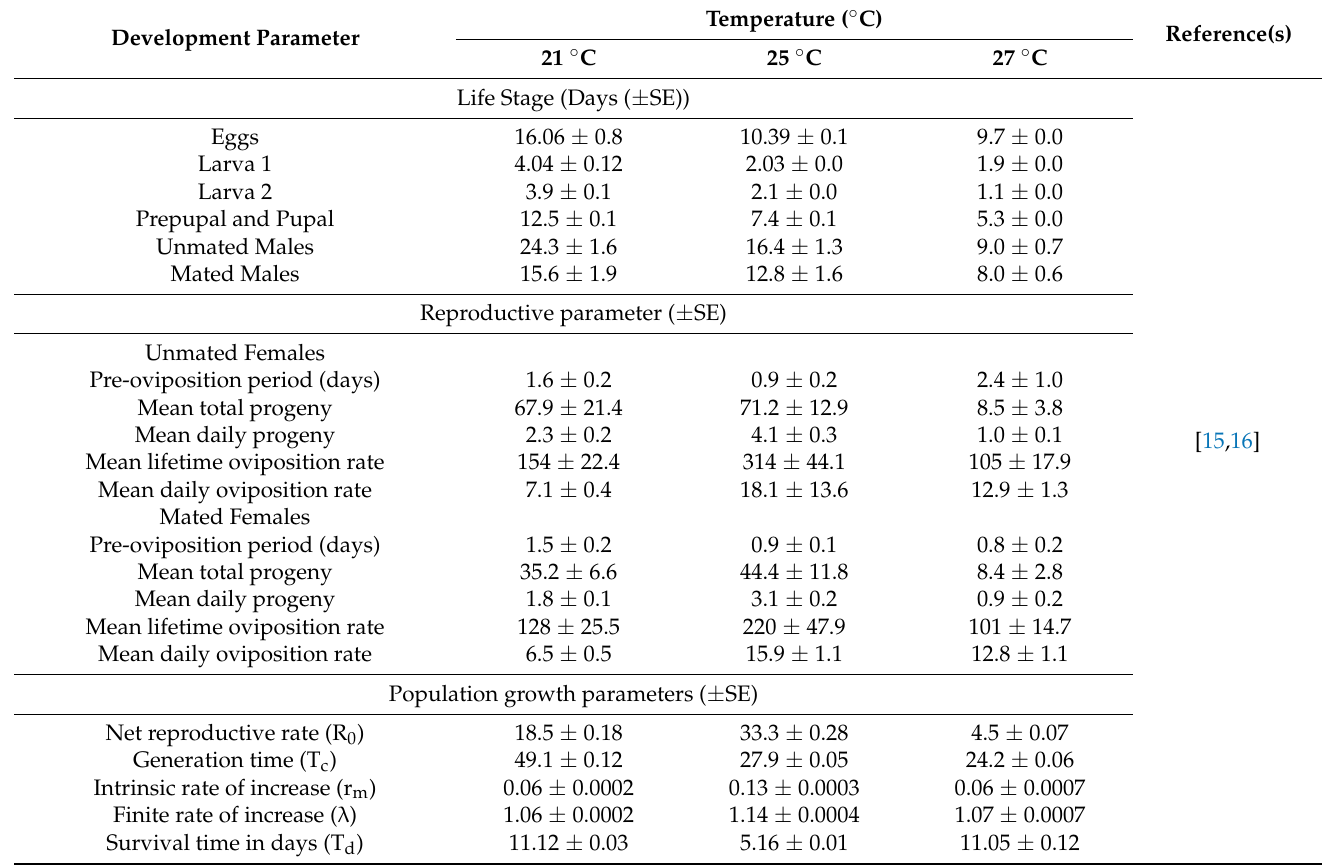
Table 2. Developmental parameters (days) of Franklinothrips vespiformis reared at different tempera-